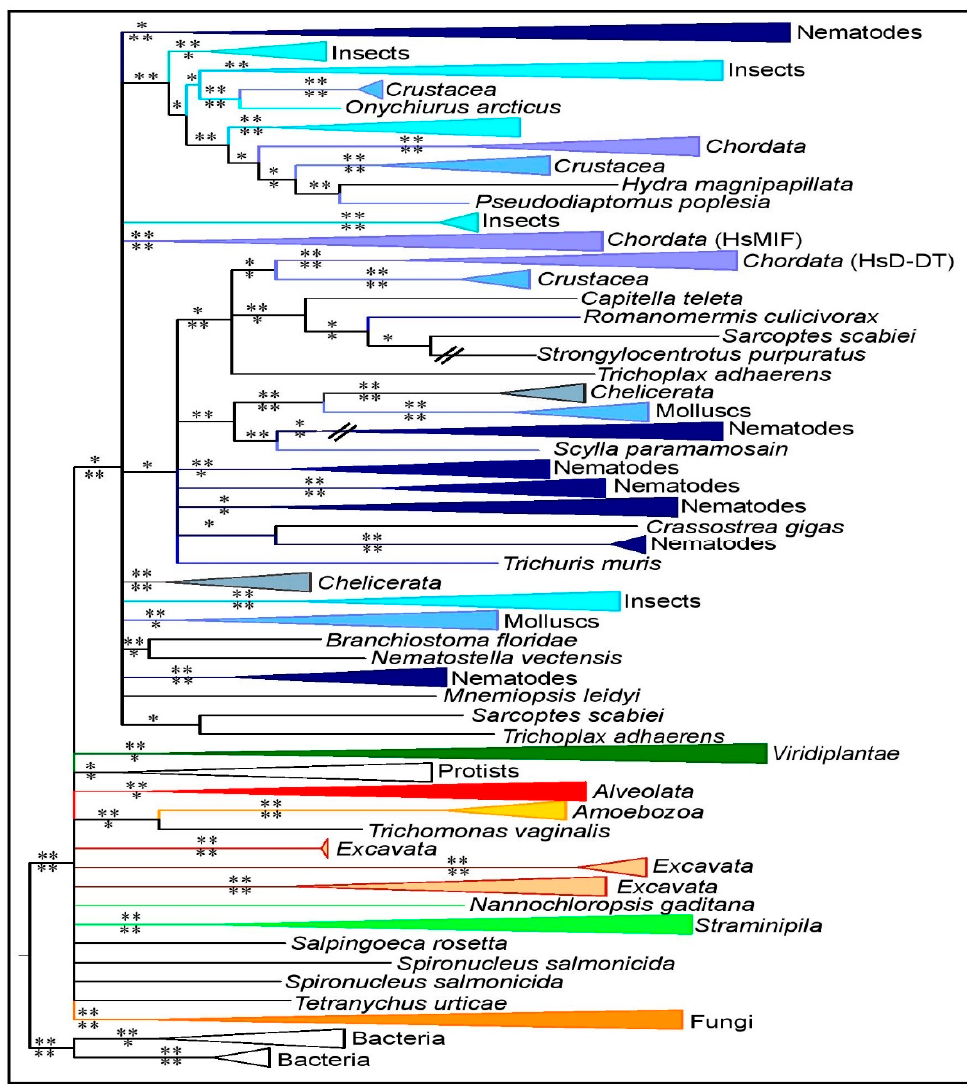
Figure 2. Overview of MIF phylogeny across eukaryotic kingdoms. Phylogenetic analysis of 720 MIF sequences based on alignments of 113 amino acid characters using the Bayesian Inference (BI) method and rooted using bacterial sequences (see Materials and Methods for details). Posterior probability (PP) support values are indicated above the branch for the BI and corresponding approximate likelihood-ratio test (aLRT) support values below the branch for the ML analysis. *: PP > 0.5 or aLRT > 0.7. **: PP > 0.7 or aLRT > 0.9. MIF clusters are colored according to the taxonomic phyla: metazoa (shades of blue), Stramenopila (light green), Archaeplastida (dark green), Alveolata (red), fungi (dark orange), Excavata (light orange), Amoebozoa (yellow), Rhizari a (pink), and Cryptophyta – Haptophyceae – Picozoa (white). Color codes of phyla are identical for all figures of the study.